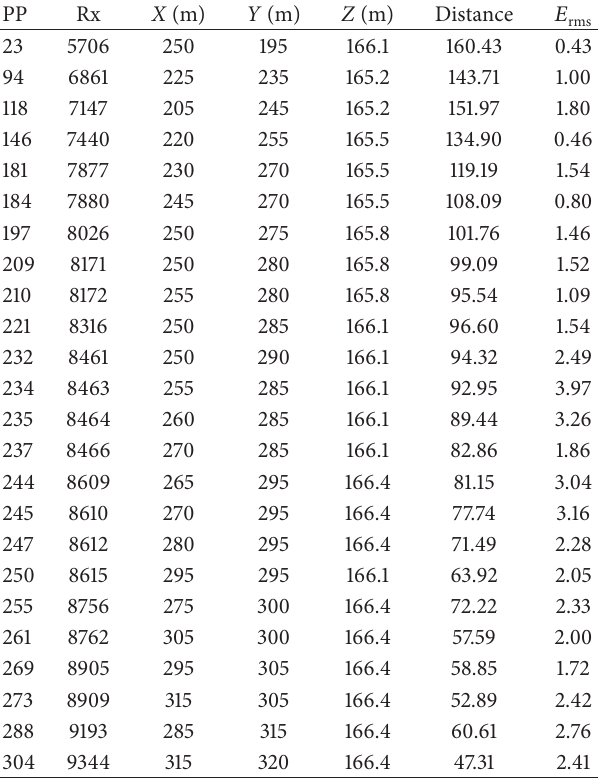
Table 1: Software prediction of total electric field strength for DCS1800 MHz.